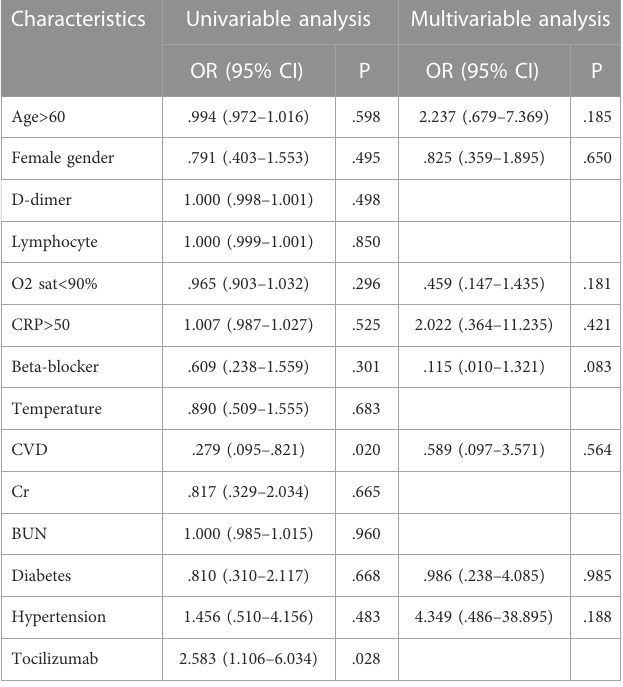
TABLE 3 Univariable and multivariable logistic regression model of predictor variables for bradycardia.